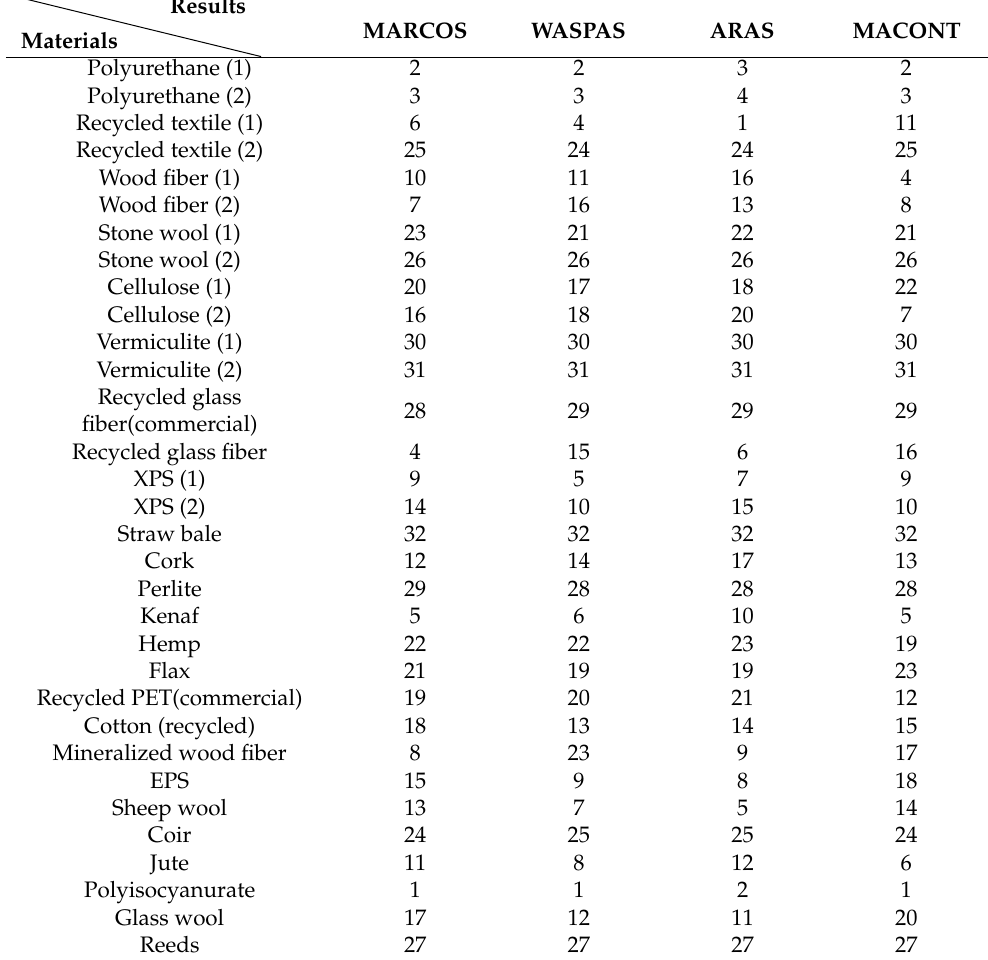
Table 12. The results of MCDM methods.